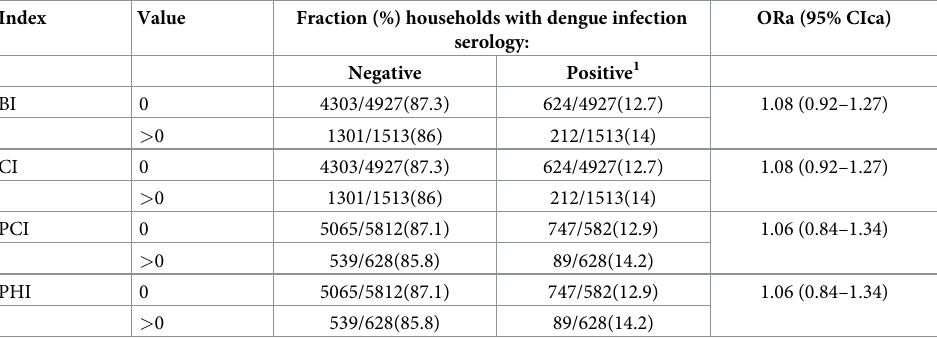
Table 1. Associations between vector indices and serological evidence of recent dengue infection in children at household